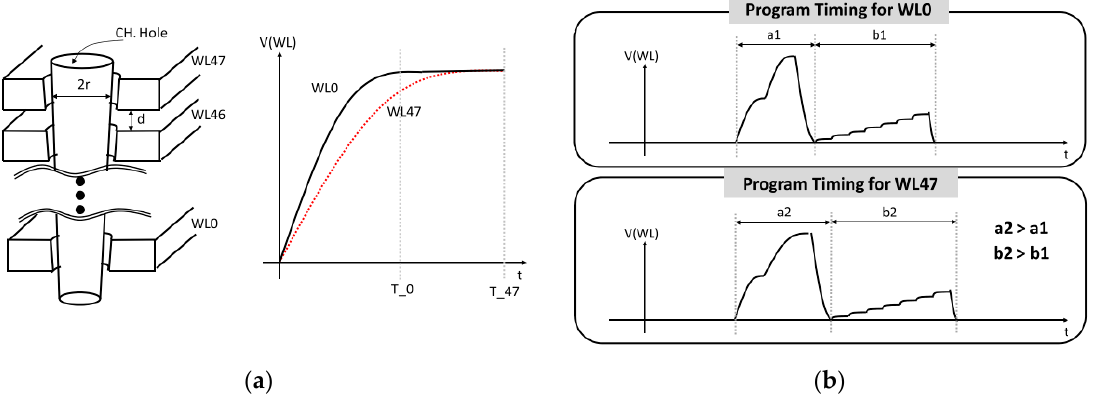
Figure 5. ( a ) WL loading variation due to channel hole CD variation. Reprinted/adapted with permission from Ref. [44], 2017, IEEE. ( b ) Variable-pulse scheme to cope with WL loading variation. Reprinted/adapted with permission from Ref. [44] , 2017, IEEE.